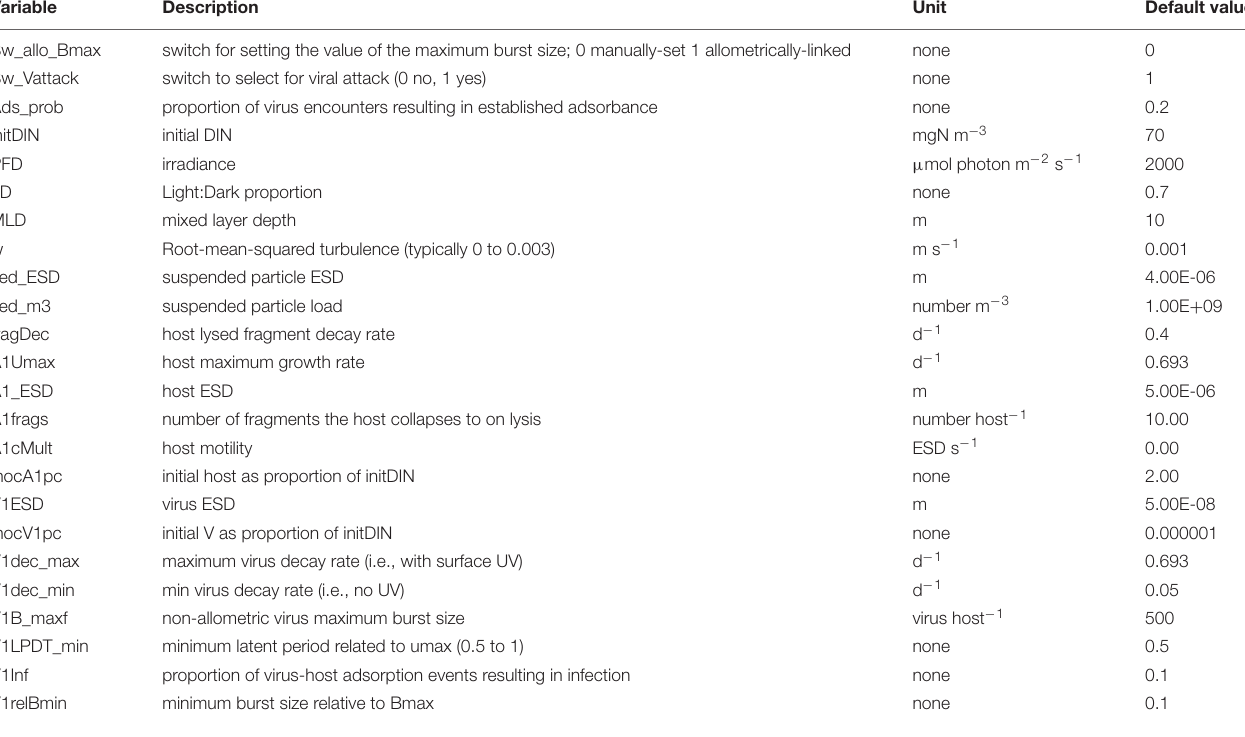
TABLE 4 | Variables changed during the simulations and the values in the default (control) simulation. ESD – equivalent spherical diameter.